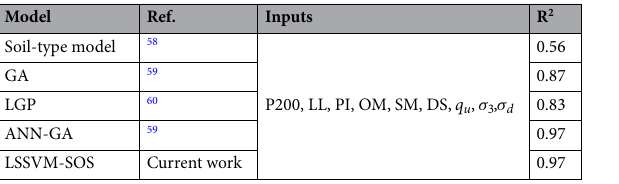
Table 8. Comparison LSSVM-SOS with prior models. GA Genetic algorithm, LGP Linear genetic programming.